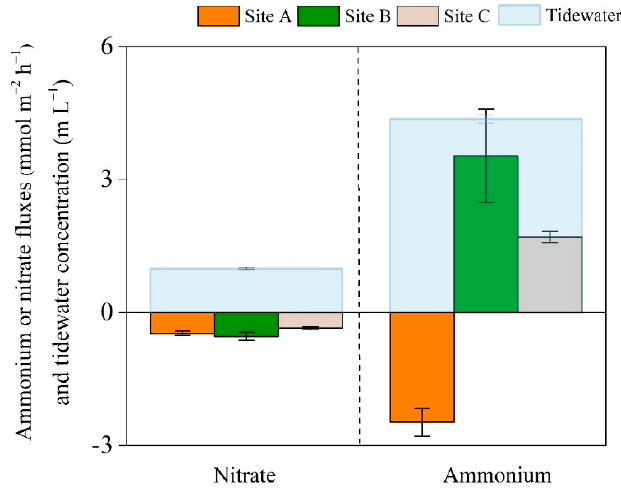
Figure 4. Fluxes of ammonium and nitrate at the sediment–water interface along the hydrological gradient. A positive flux means that ammonium or nitrate are released from the sediment to the overlying water, whereas a negative flux means that ammonium or nitrate are di ff used from the overlying water to the sediment. Blue areas represent the ammonium or nitrate concentration of tidewater. Vertical bars represent standard errors (n = 3). Sites A, B, and C refer to the high tidal flat, interaction zone between high and middle tidal flats, and middle tidal flat, respectively.